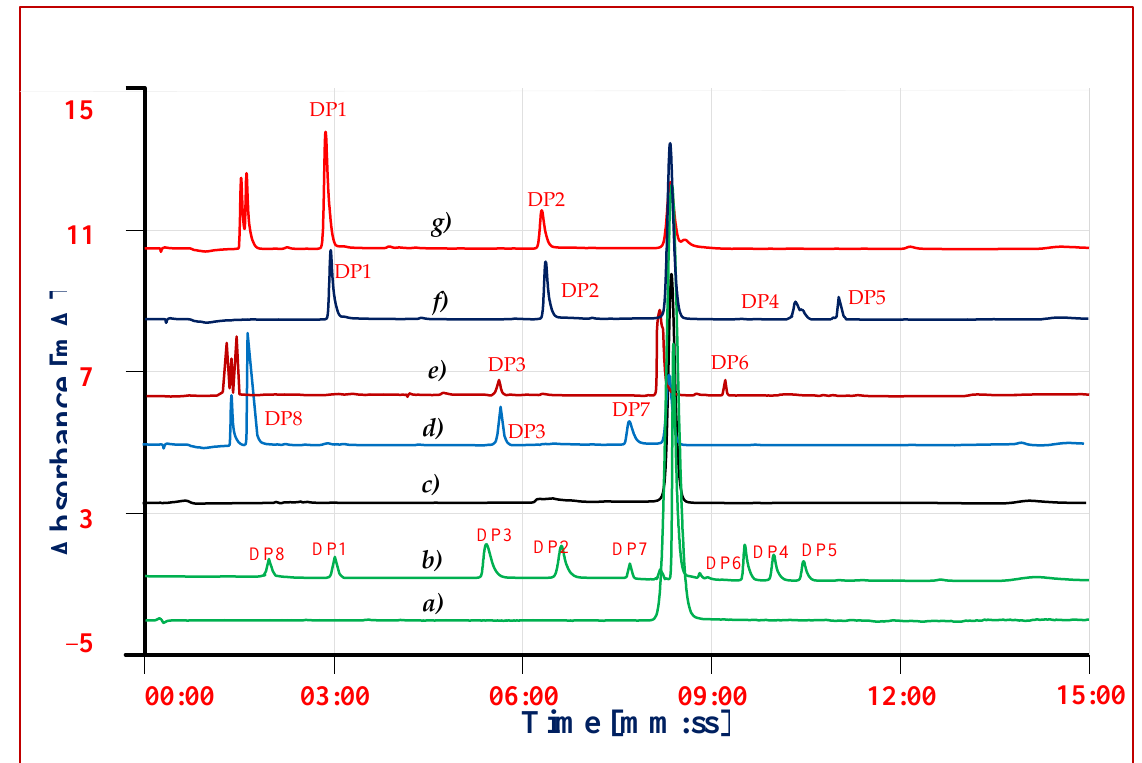
Figure 3. Chromatograms of forced degradation studies and reference standards ( a ) VEL reference standard ( b ) VEL composite reference standards, ( c ) VEL-CSD thermal study, ( d ) Acid degradation ( e ) Alkaline degradation, ( f ) Oxidative degradation ( g ) Photolytic degradation.